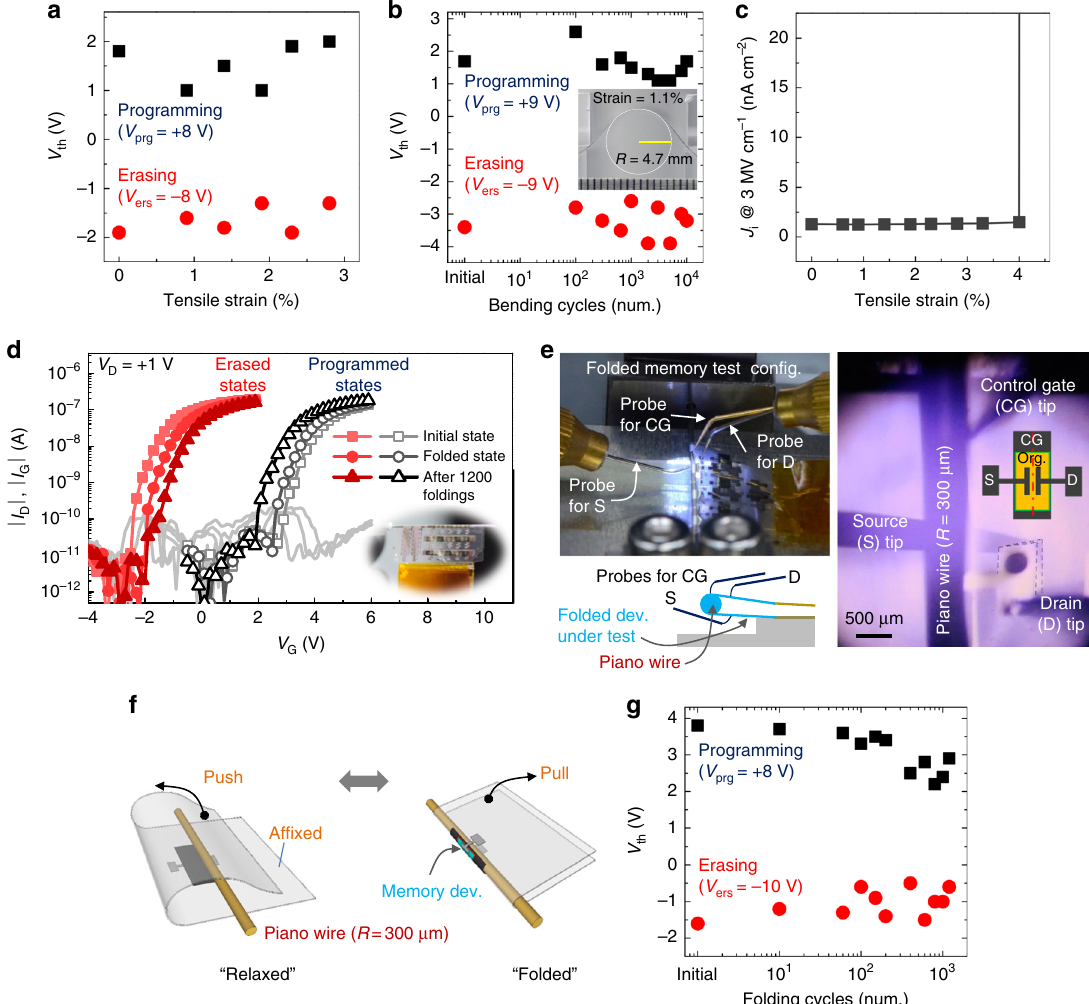
Fig. 3 Characteristics of the proposed fl exible fl ash memory under or after mechanical deformation. a , b V th measured upon programming/erasing operations for devices under various bending induced tensile strains ( a ), and V th measured after repetitive bending cycles with tensile strain of 1.1% ( b ), ( inset : a photograph of the fl exible organic fl ash memory fabricated on 100 μ m-thick PET fi lms). c J i values of Al/pEGDMA (40 nm)/Al devices at an E i of 3 MV cm − 1 measured as a function of various tensile strains. d Transfer memory characteristics of the proposed memory devices fabricated on 6 μ m-thick Mylar TM substrates ( “ ultrathin Mylar ” hereafter) in their fl at and folded states, and after 1200-time folding cycles. Folding radius is 300 μ m and de fi ned by the radius of a piano wire. Inset shows a photograph of the folded fl ash memory fabricated on the Mylar TM fi lm. e Photograph of a memory device on the ultrathin Mylar being characterized under the folded state. A top-view microscope image and a side-view probing diagram are also presented to show that folding-induced strain is applied exactly along the channel parallel to the long edges of S and D electrodes as shown in the schematic diagram presented in the inset . Such alignment can be witnessed by the contact pads (shown as areas surrounded by the dashed lines ) of S and D that are overlapped each other. Note that the probe for S makes a contact from underneath the folded device. f A schematic diagram showing the method for alternating between “ relaxed ” and “ folded ” states for measurement of memory characteristics after repeated folding cycles. g V th of the memory on ultrathin Mylar substrates measued upon programming/erasing operations after repeated folding cycles at 300 μ m bending radius vs. the number of folding